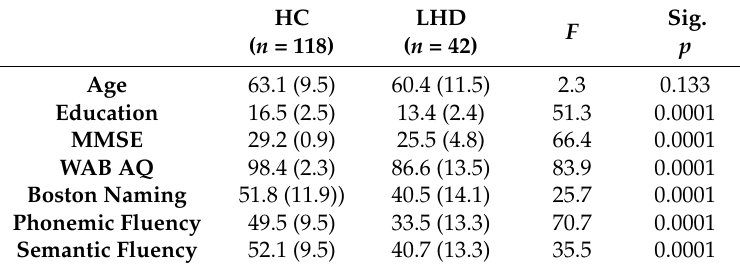
Table 2. Subject characteristics and screening measures